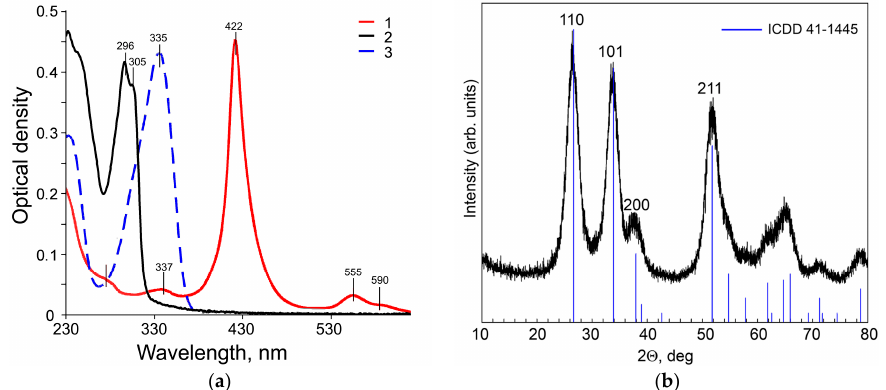
Figure 2. ( a ) UV-Vis absorption spectra of CuChPh (1); CuBiPy (2); CuAzCr (3) in CH 3 CN; C complex = 3 × 10 − 5 M. ( b ) XRD pattern of nanocrystalline SnO 2 powder. ICDD data for SnO 2 cassiterite phase (41-1445) are presented as a reference.